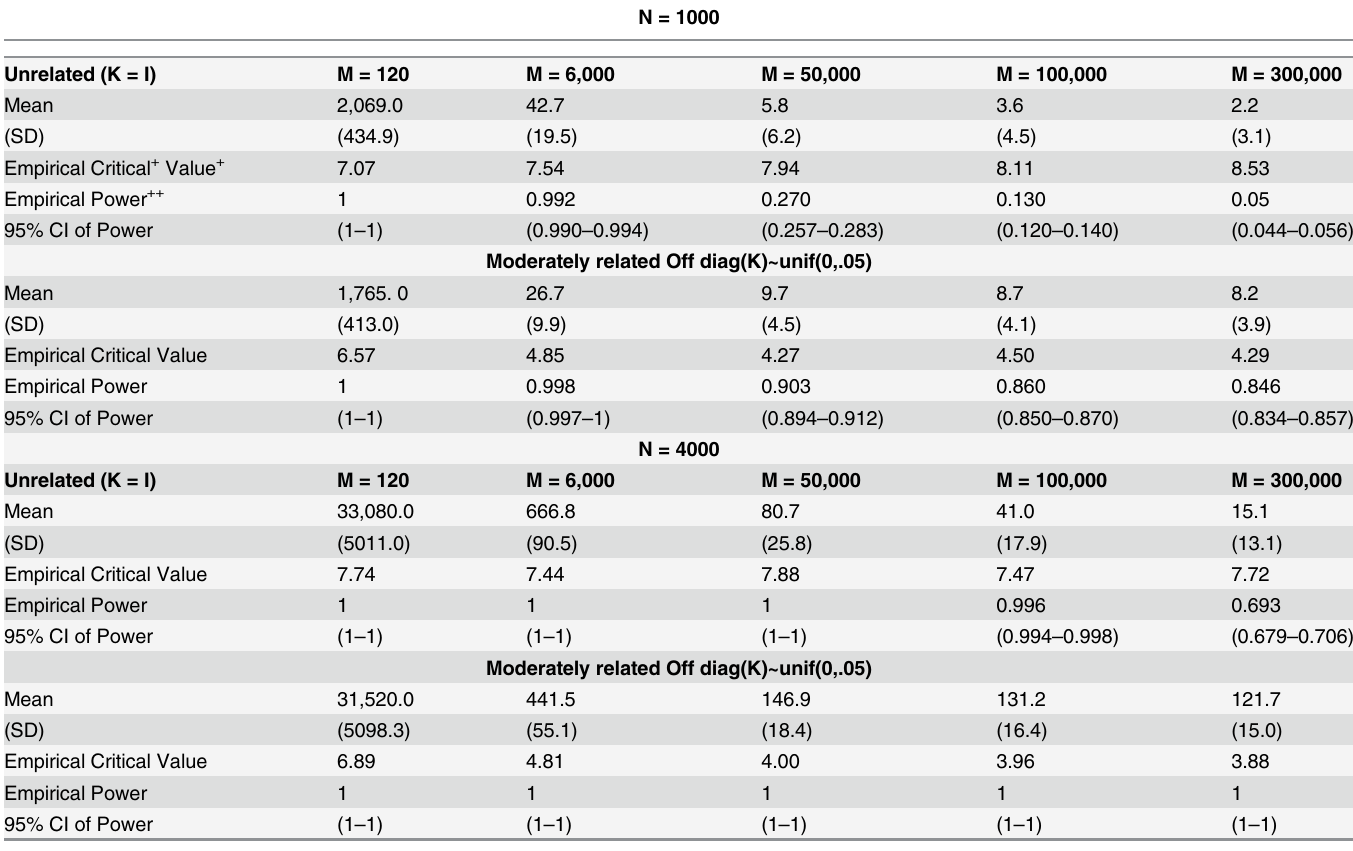
+ The empirical upper 5 percent critical value was computed under the null (h 2 = 0) from 3,000 simulations ++ Power was computed as the fraction of simulations for which T 2 was greater than the empirical critical